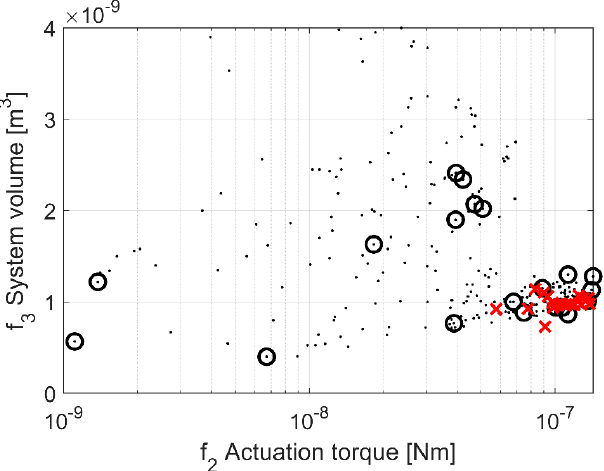
Figure 9. f 2 –f 3 projection of the objective space: dot—individuals, cross—NSGA-III solutions, circle—MP-NSGA solutions.